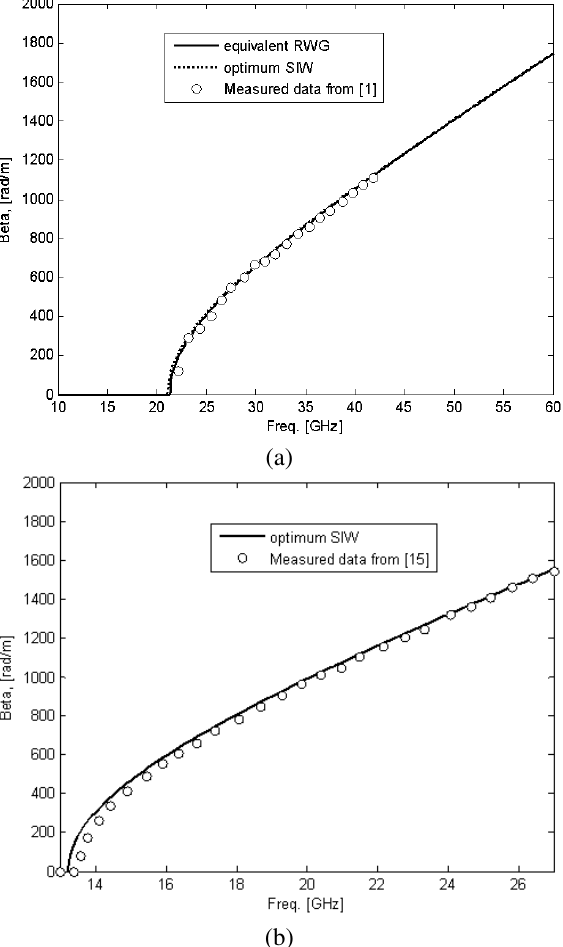
Figure 6: Propagation constant of fundamental mode TE 10 versus frequency for: (a) (cid:15) r = 2 . 2 , d=0.8 mm, p=1.5 mm, Weq=4.8 mm. (b) (cid:15) r = 9 . 9 , d=0.635 mm, p=1.016 mm, Weq=3.97